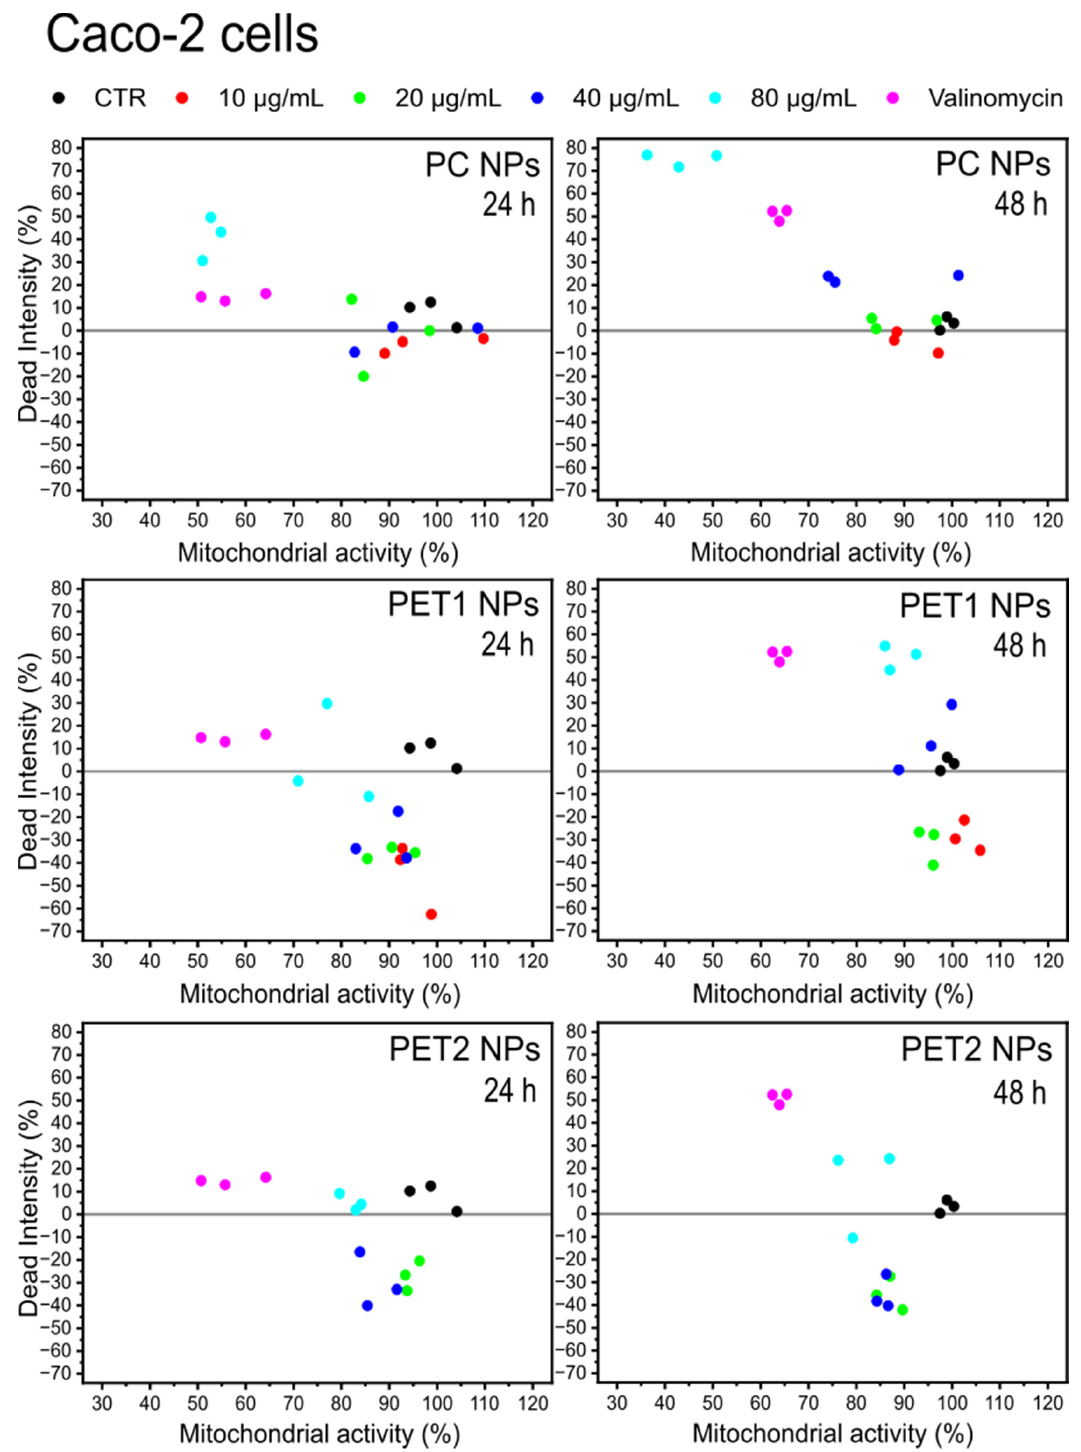
Figure 7. Two-way analysis of Caco-2 cells exposed to PC, PET1 or PET2 NPs at concentrations ranging between 10 and 80 µg/mL for 24 or 48 h. Valinomycin was used as positive control. Results are expressed as a function of two different parameters: mitochondrial activity and cellular membrane damage. Data are reported as the average of three independent experiments (each run in triplicate).